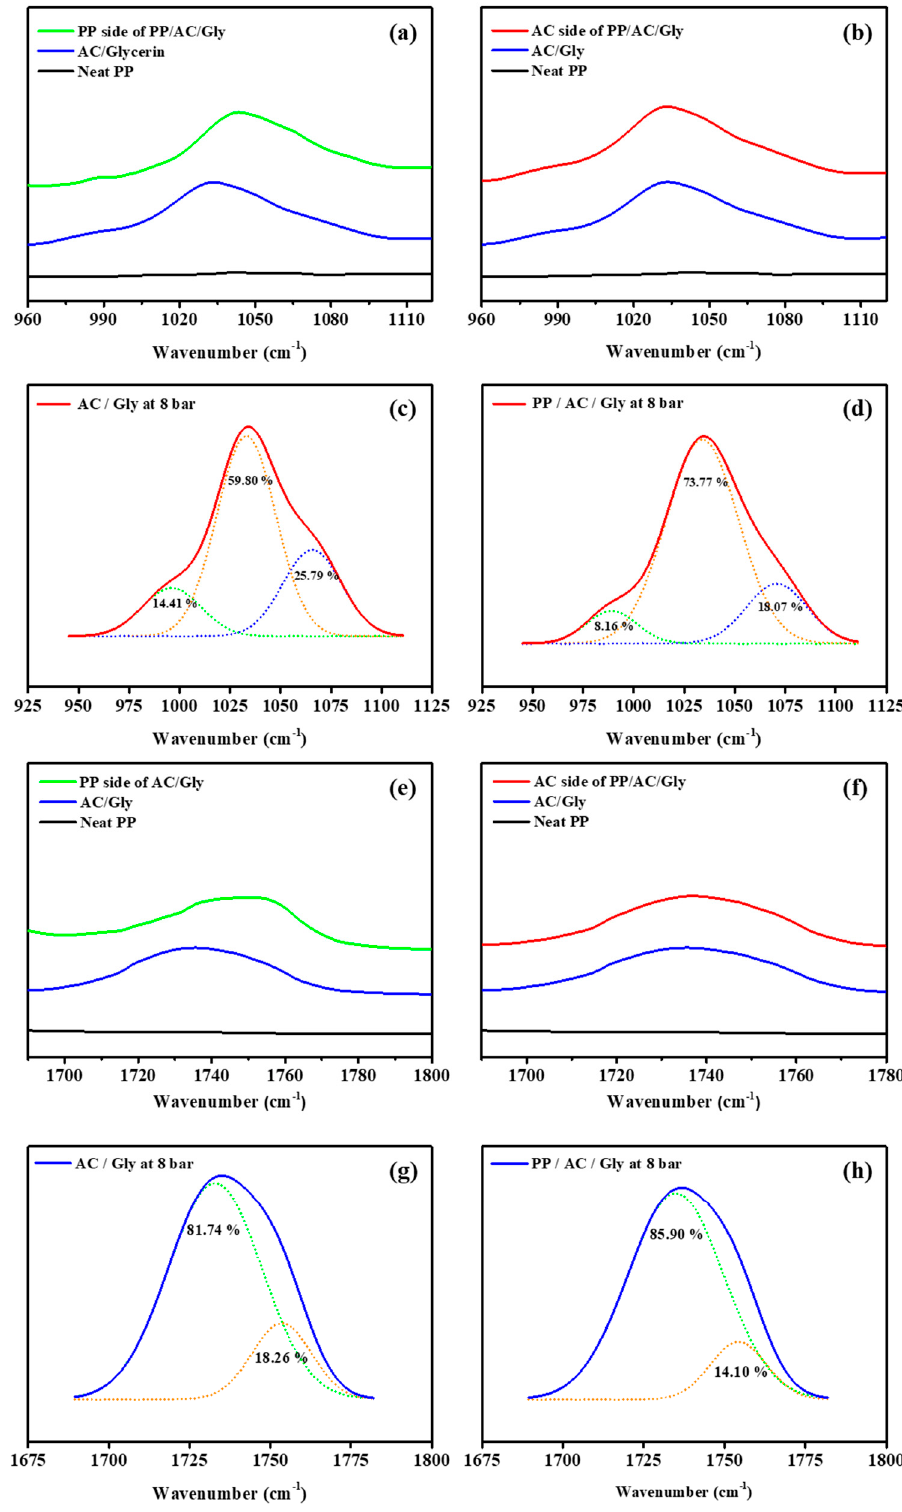
Figure 5 . ( a , b ): FT-IR spectra for ether (960–1100 cm − 1 ), ( c , d ) deconvoluted data of the ether func- tional group (960–1100 cm − 1 ) of the PP/AC/Gly separators, ( e , f ) FT-IR spectra for the carbonyl func- tional group (1690–1780 cm − 1 ) of the PP/AC/Gly separators, and (( g , h ) and Table 3) deconvoluted data of the carbonyl functional group (1690–1780 cm − 1 ) of the PP/AC/Gly separators. Table 3. Deconvoluted % of FT-IR data (carbonyl functional group).